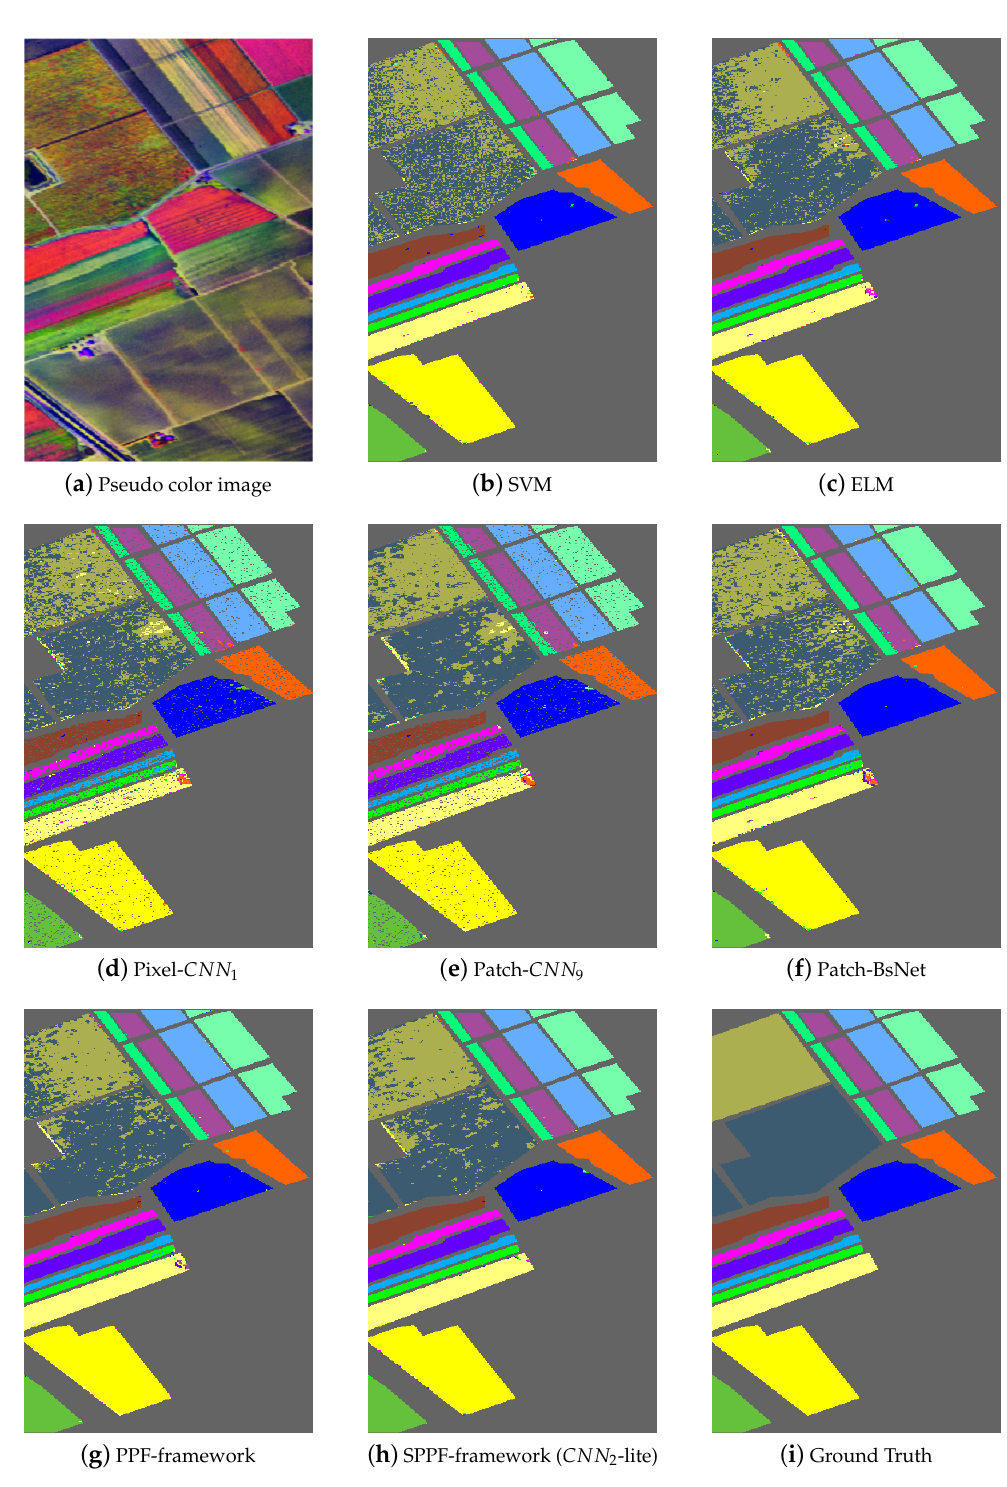
Figure 7. Results on the University of Salinas dataset. ( a ) Pseudo color image of the scene. ( b – h ) Results from competing methods. ( i ) The ground truth. Our algorithm achieves the best classification accuracy among the competing methods. (Best viewed in